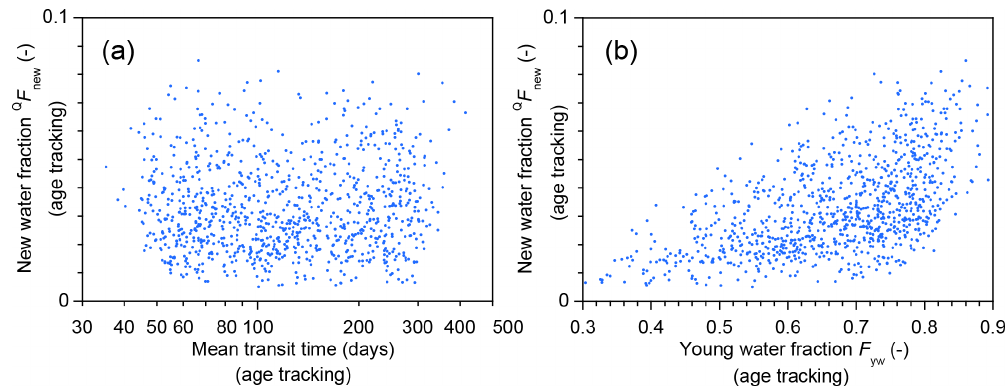
Figure 3. Average new water fractions (same-day precipitation in streamflow) for the 1000 simulated catchments (i.e., 1000 model parameter sets) shown in Fig. 2, compared to the catchment mean transit time and the young water fraction F yw (the fraction of streamflow younger than 2.3 months). All values plotted here are determined from age tracking within the benchmark model, and thus are true values, without any errors associated with estimating these quantities from tracer data. Neither mean transit time nor the young water fraction can reliably predict the fraction of new water in